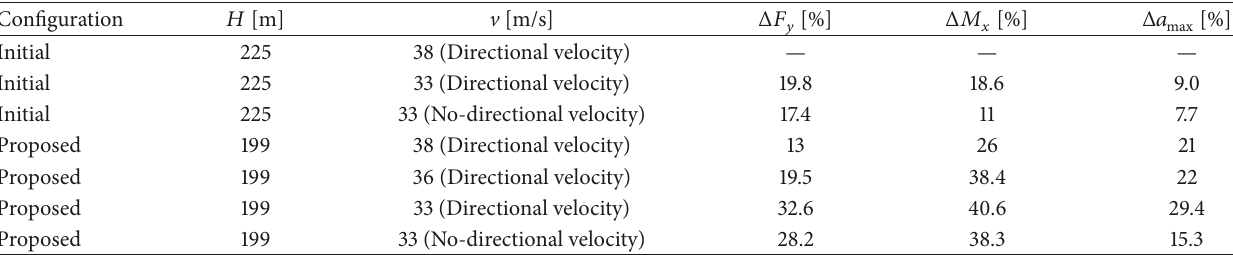
Table 7: Structural improvements for different velocities and heights: reductions in the base shear and bending moments and the acceleration response of the top floor.